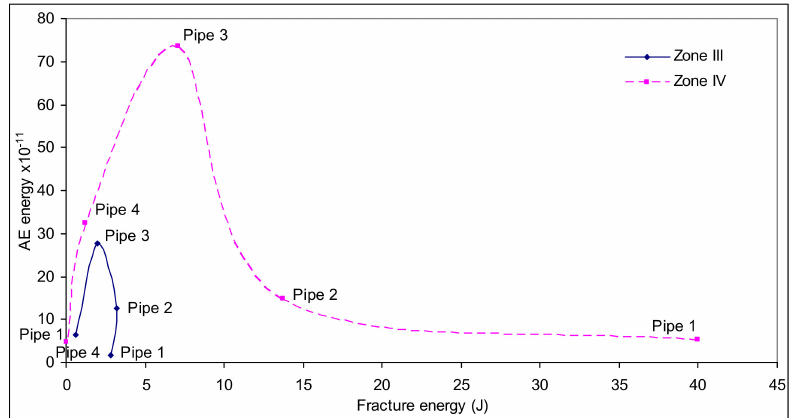
Figure 12. Total AE energy and fracture energy for Zones III and